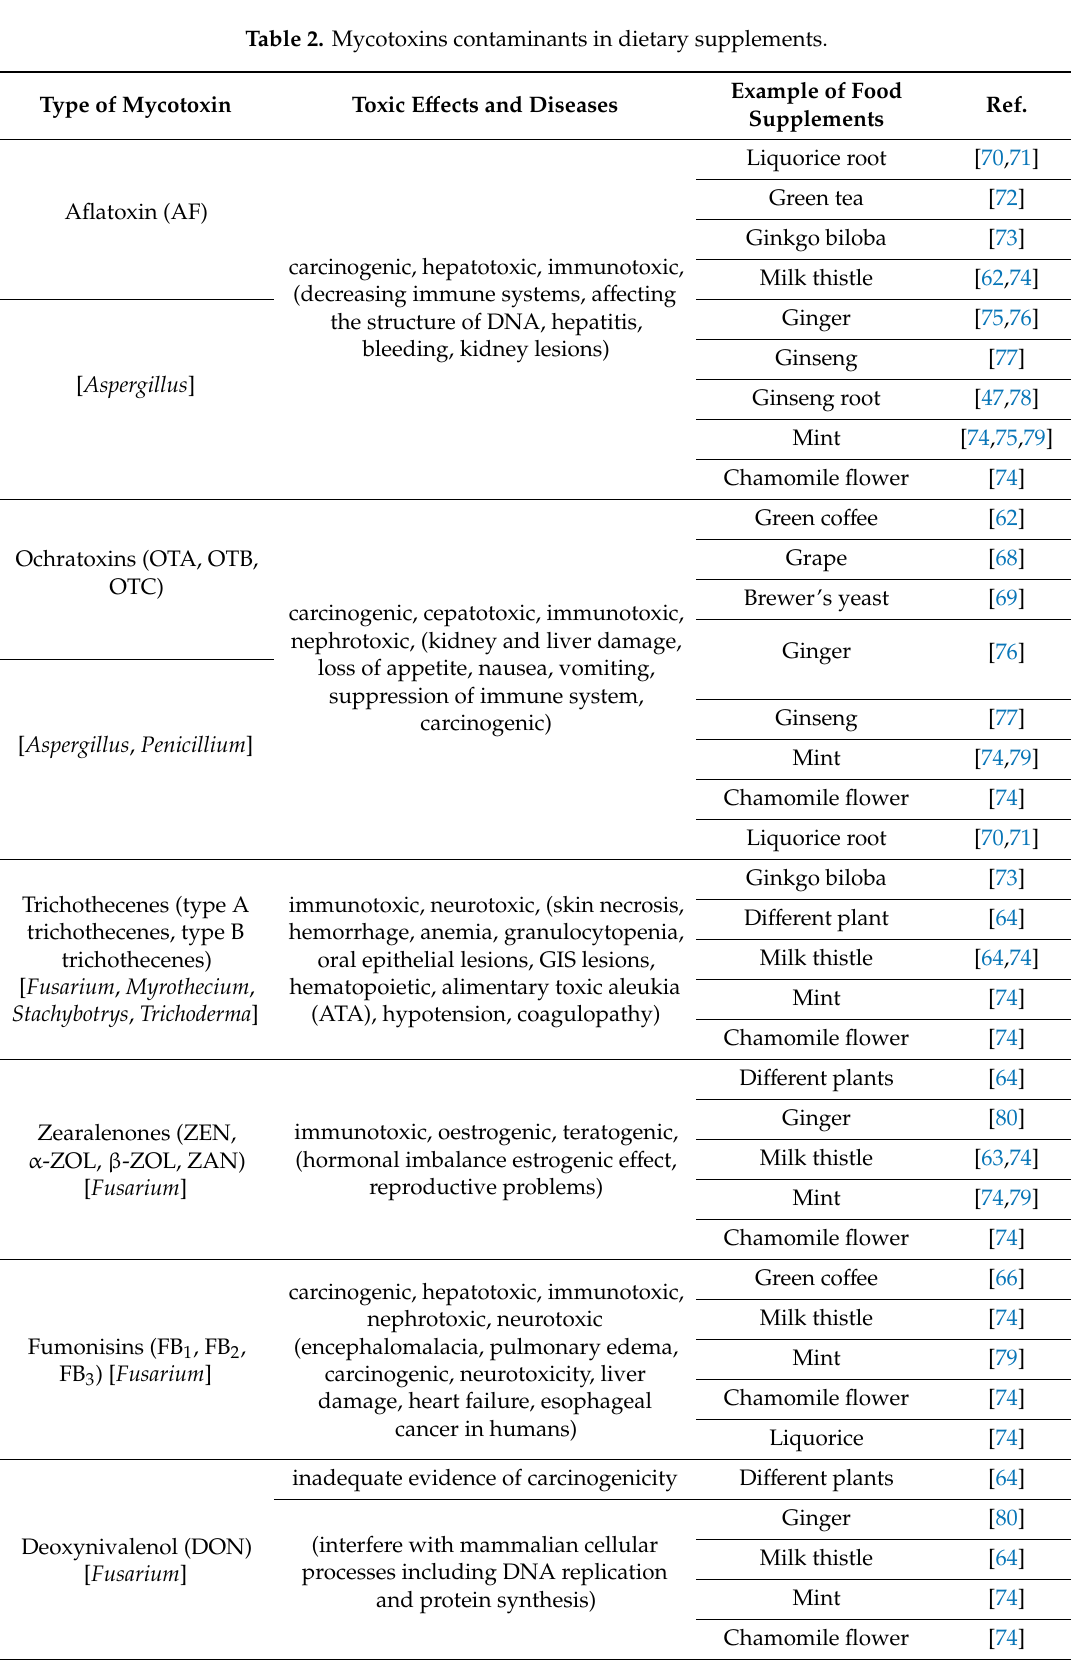
Table 2. Mycotoxins contaminants in dietary